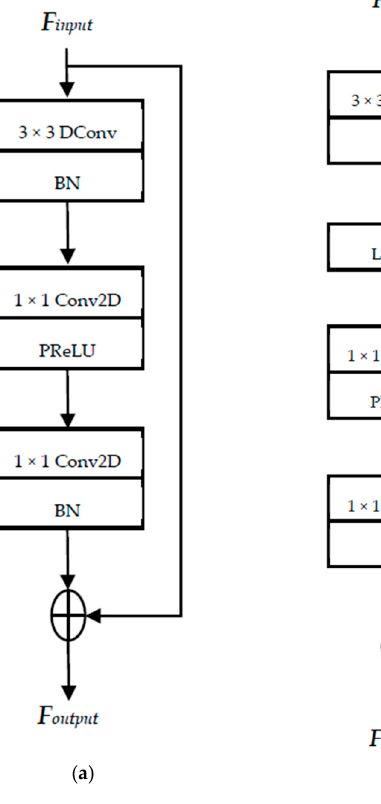
Figure 7. ECN building block with different integration strategies. ( a ) ECN block; ( b ) ECN block integrated with LCAM after the depthwise convolution along with batch normalization operation; ( c ) ECN block integrated with LCAM after the first pointwise convolution along with PReLU activa- tion function; ( d ) ECN block integrated with LCAM at the end. Here, ‘DConv’ represents Depthwise Convolution, while ‘1 × 1 Conv2D’ represents pointwise convolution. Through the reported results in Tables 5 and 6, ConvFaceNeXt_LCAM has the best might be due to the placement of LCAM at the rear bo tt om position of an ECN block.